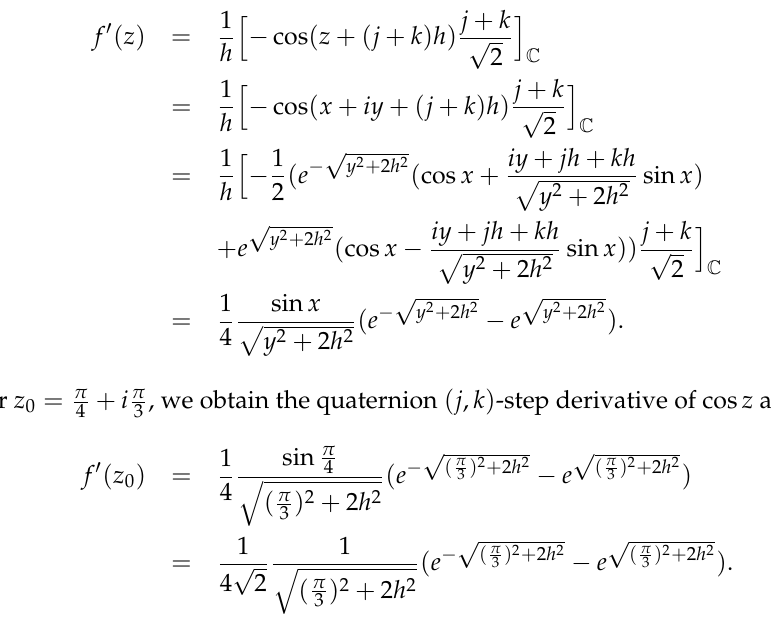
. It confirms to us how close the 8